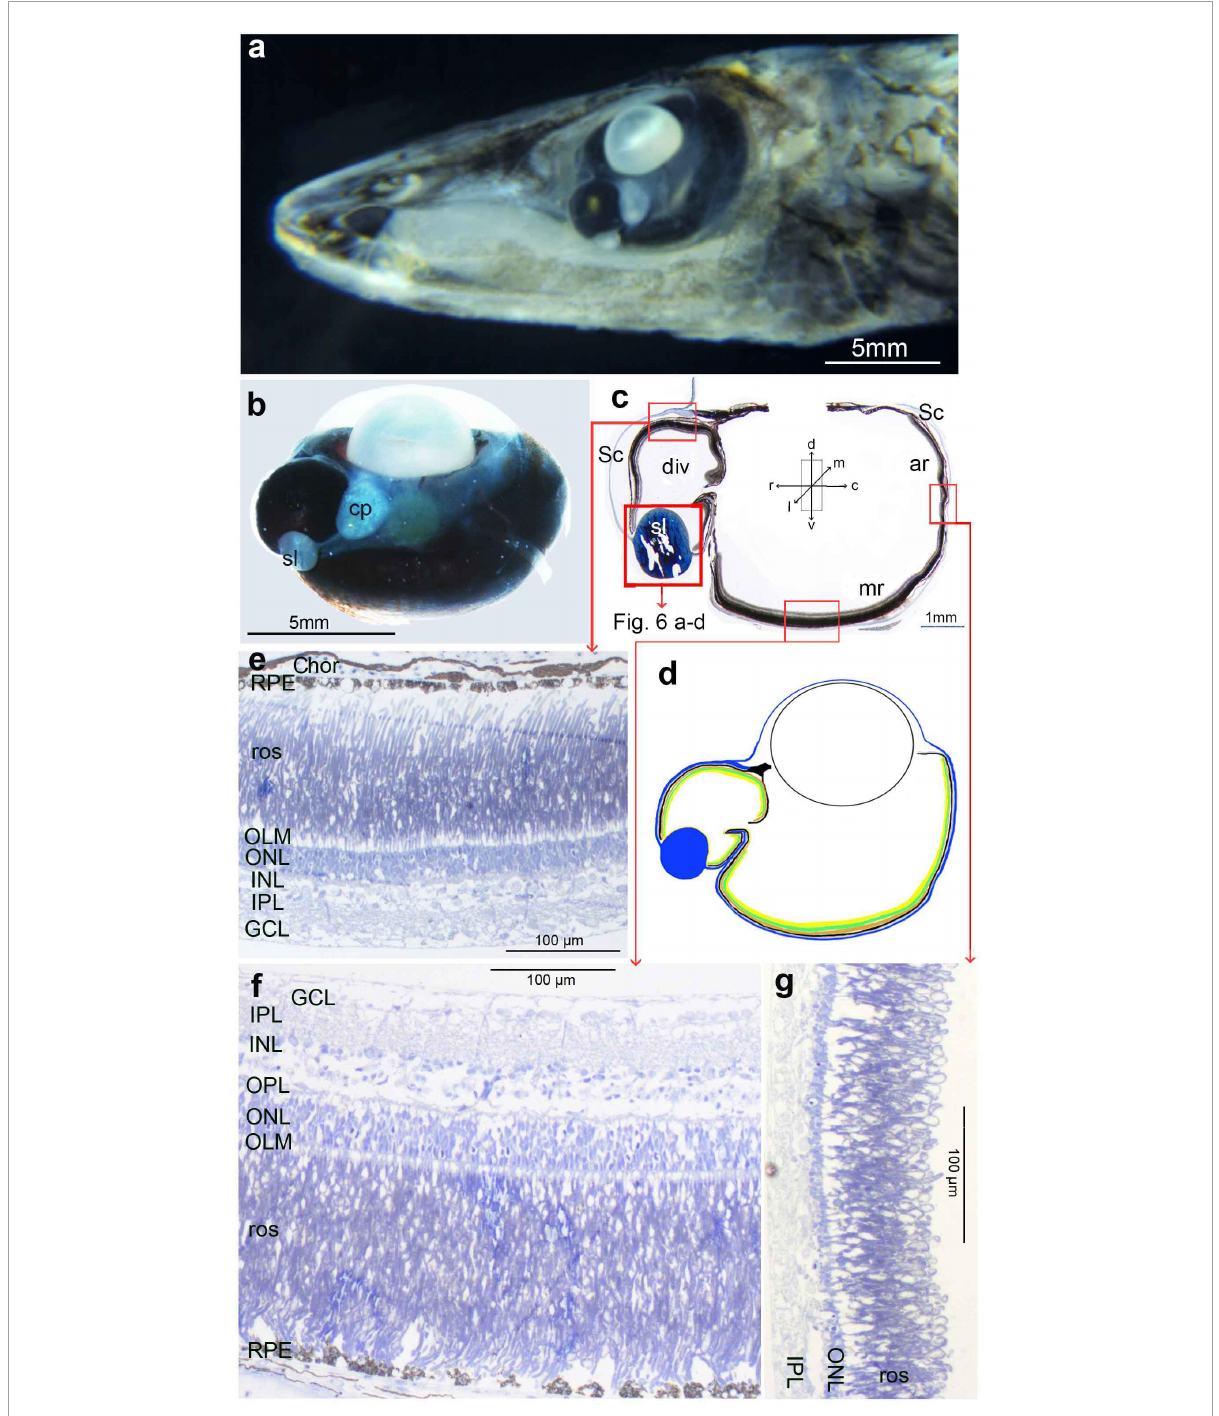
FIGURE5 Bathylychnops exilis : (a) Head of an adult specimen (SL 200 mm); (b) Isolated eye showing the rostrolateral diverticulum with a ventral scleral lens, and a caudal ‘corneal projection’; (c) Thick section of the left eye showing the main globe and the diverticulum. The cornea of the main eye has been removed and during preparation the retina lining the diverticulum has become detached from the sclera laterally; (d) Schematic of an approximately transverse section of the eye colour coded as in Figure 1 ; (e) Radial semithin section of the retina in the dorsal diverticulum; (f) radial semithin section of the main retina; (g) radial semithin section of the accessory retina. The orientation arrows shown in panel (c) are applicable to all panels but see Materials and Methods for comments on deviations from the transverse plane in histological